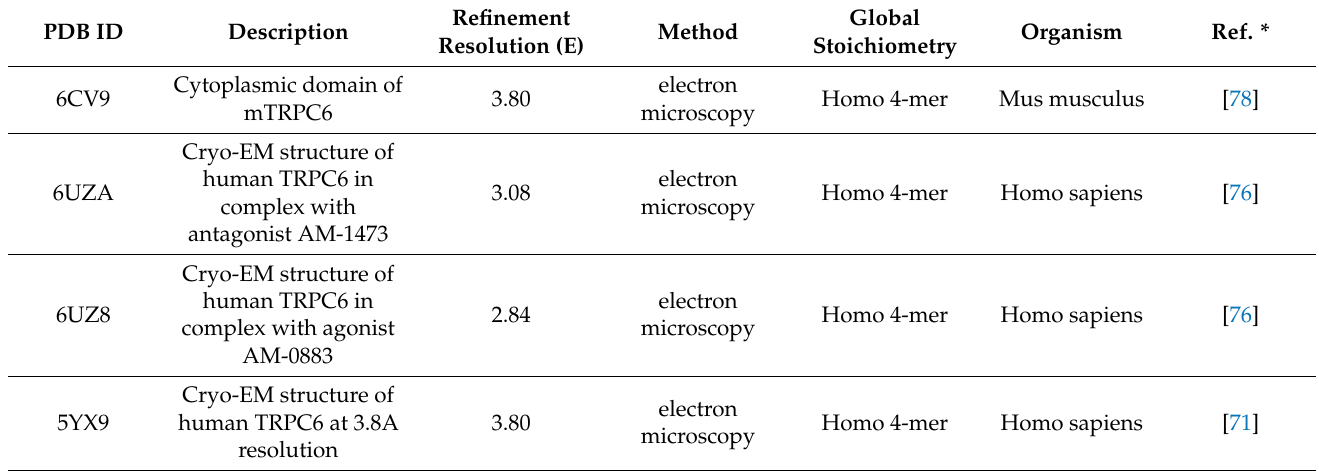
Table 1. List of TRPC6 3D molecular models available at